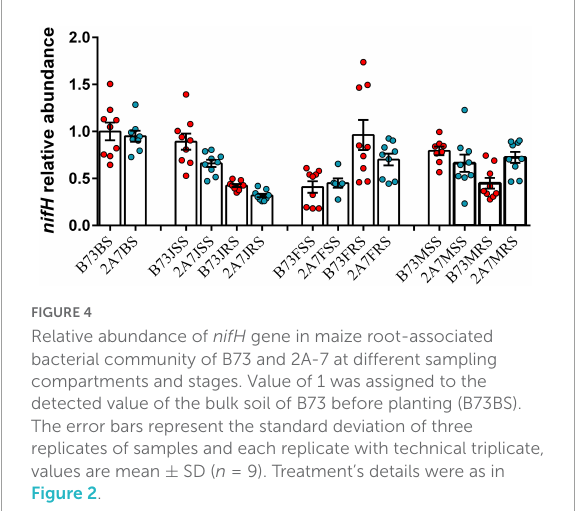
FIGURE4 Relative abundance of nifH gene in maize root-associated bacterial community of B73 and 2A-7 at different sampling compartments and stages. Value of 1 was assigned to the detected value of the bulk soil of B73 before planting (B73BS). The error bars represent the standard deviation of three replicates of samples and each replicate with technical triplicate, values are mean ± SD ( n = 9). Treatment’s details were as in Figure 2 .